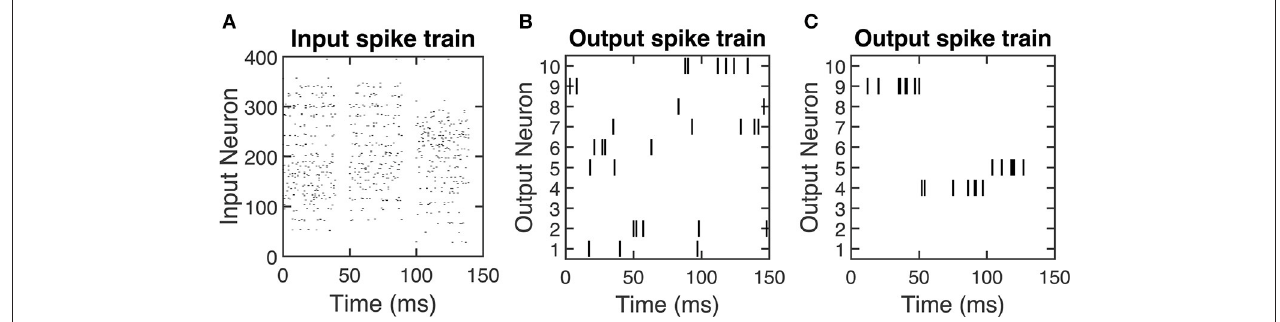
FIGURE 2 | Spike raster plots showing examples of (A) input spiking activity, (B) output spiking activity for an untrained SNN, and (C) output spiking activity for a trained SNN. For (B) and (C) , 10 output neurons’ spiking activities are selected as a representative example. After the SNN is trained, the output spike firing activity is more coordinated, which is indicated by the output neurons selectively firing to certain input stimuli. The time duration on the x axis indicates the presentation of training samples. Since the output neuron firing rate is 200Hz, therefore there are around 10 spikes (# of spikes = presentation time × frequency = 50ms × 0.001 × 200Hz = 10) will be generated within 50ms presentation time.